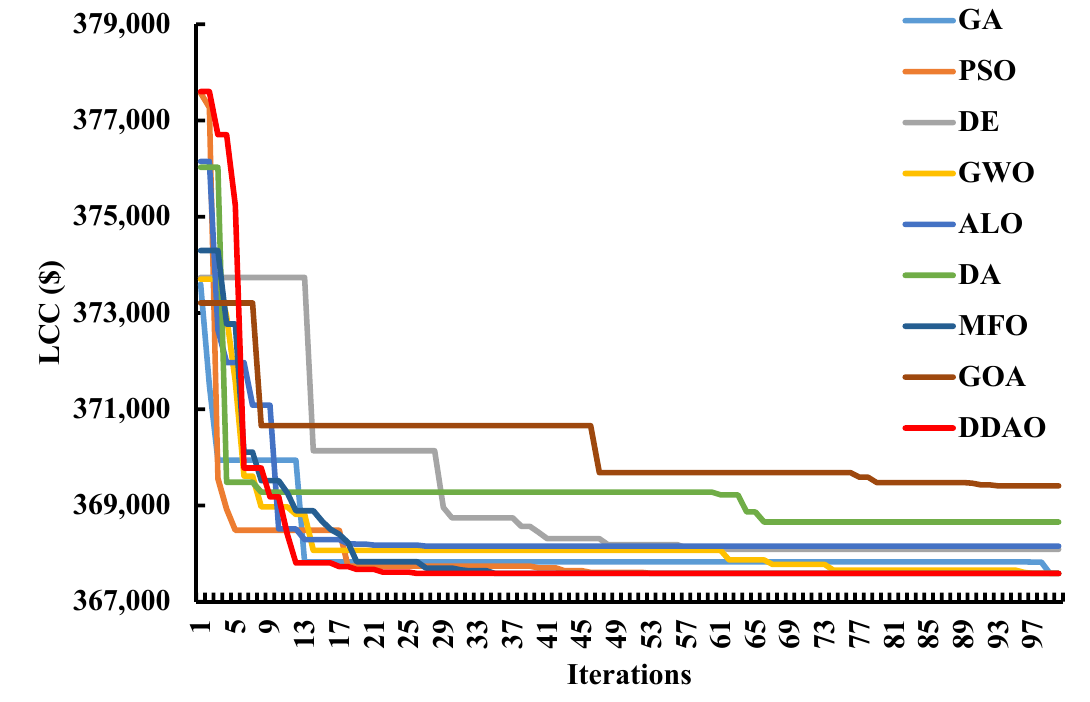
Figure 9. Convergence curves of the configuration made up of Ni-Fe battery.